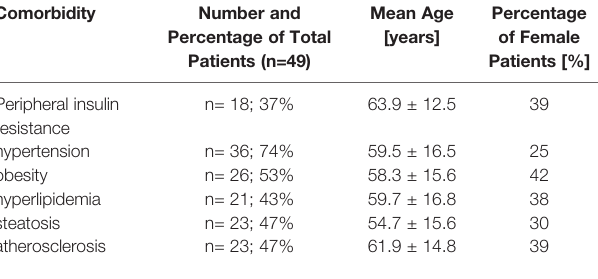
TABLE 1 | Metabolic comorbidities in the investigated